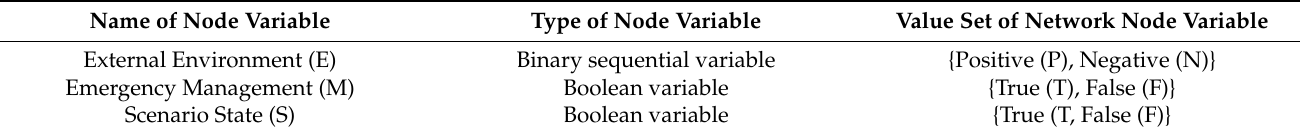
Table 4. Type and value set of network node variable.